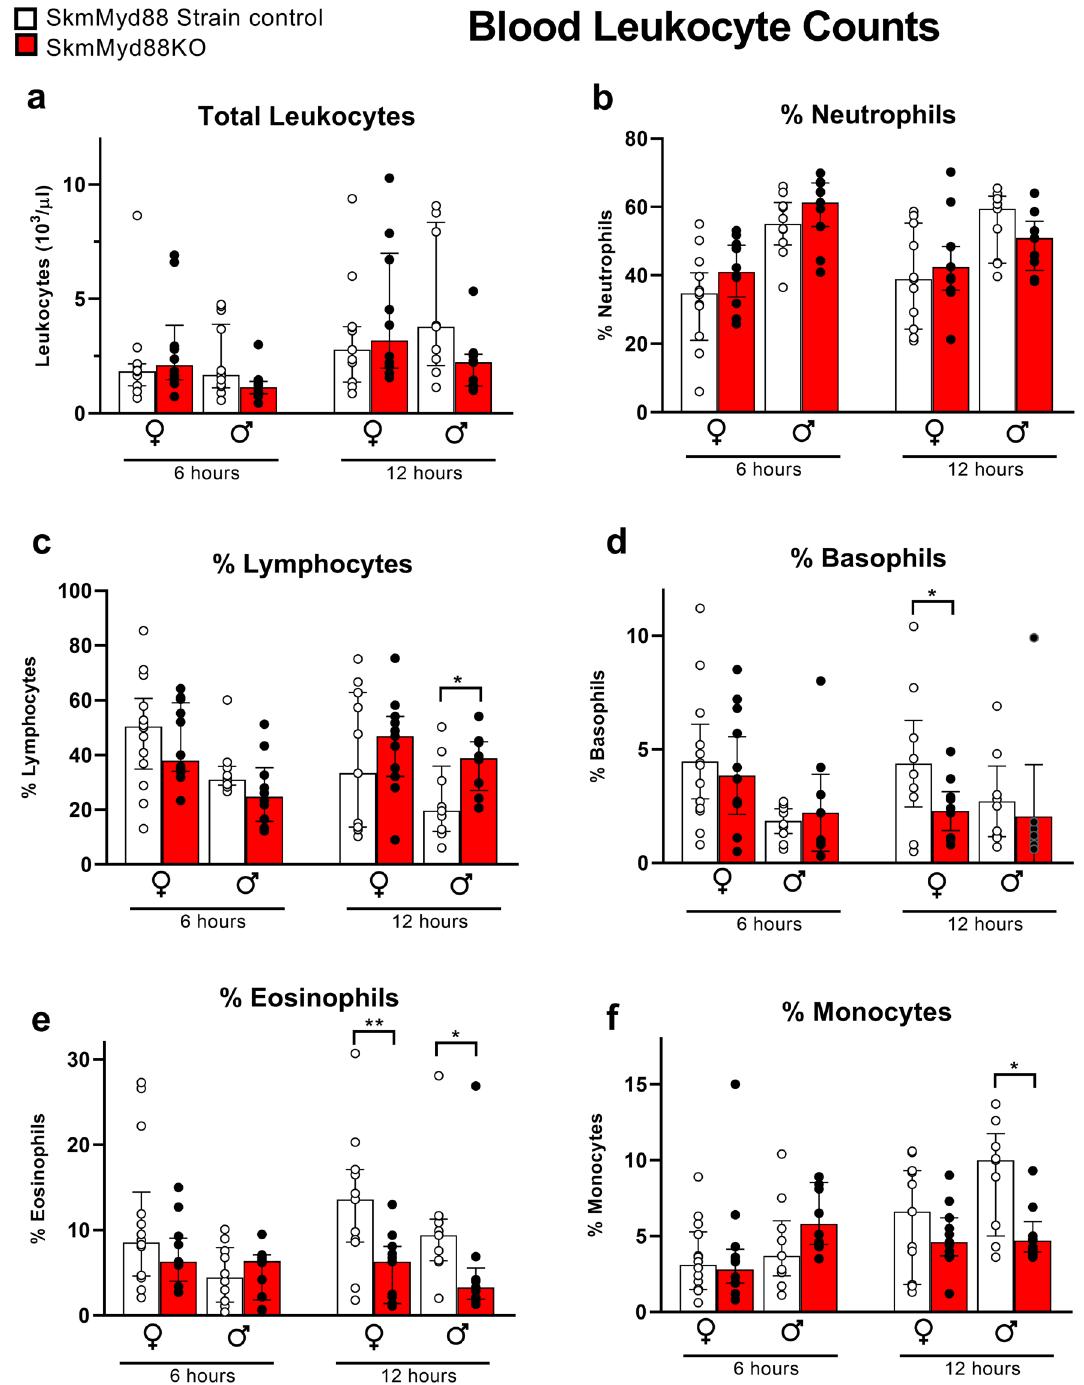
Figure 5. Effects of skmMyd88 knockout on immune cell populations in the blood. SkmMyd88KO red bars, strain matched control, white bars. Groups were tested by orthogonal comparisons within sex and compared to strain matched controls. *P < 0.05, **P < 0.01. n = 9–12 in each group. Data expressed as medians ± 25–75% quartiles. All data met a false discovery rate of <